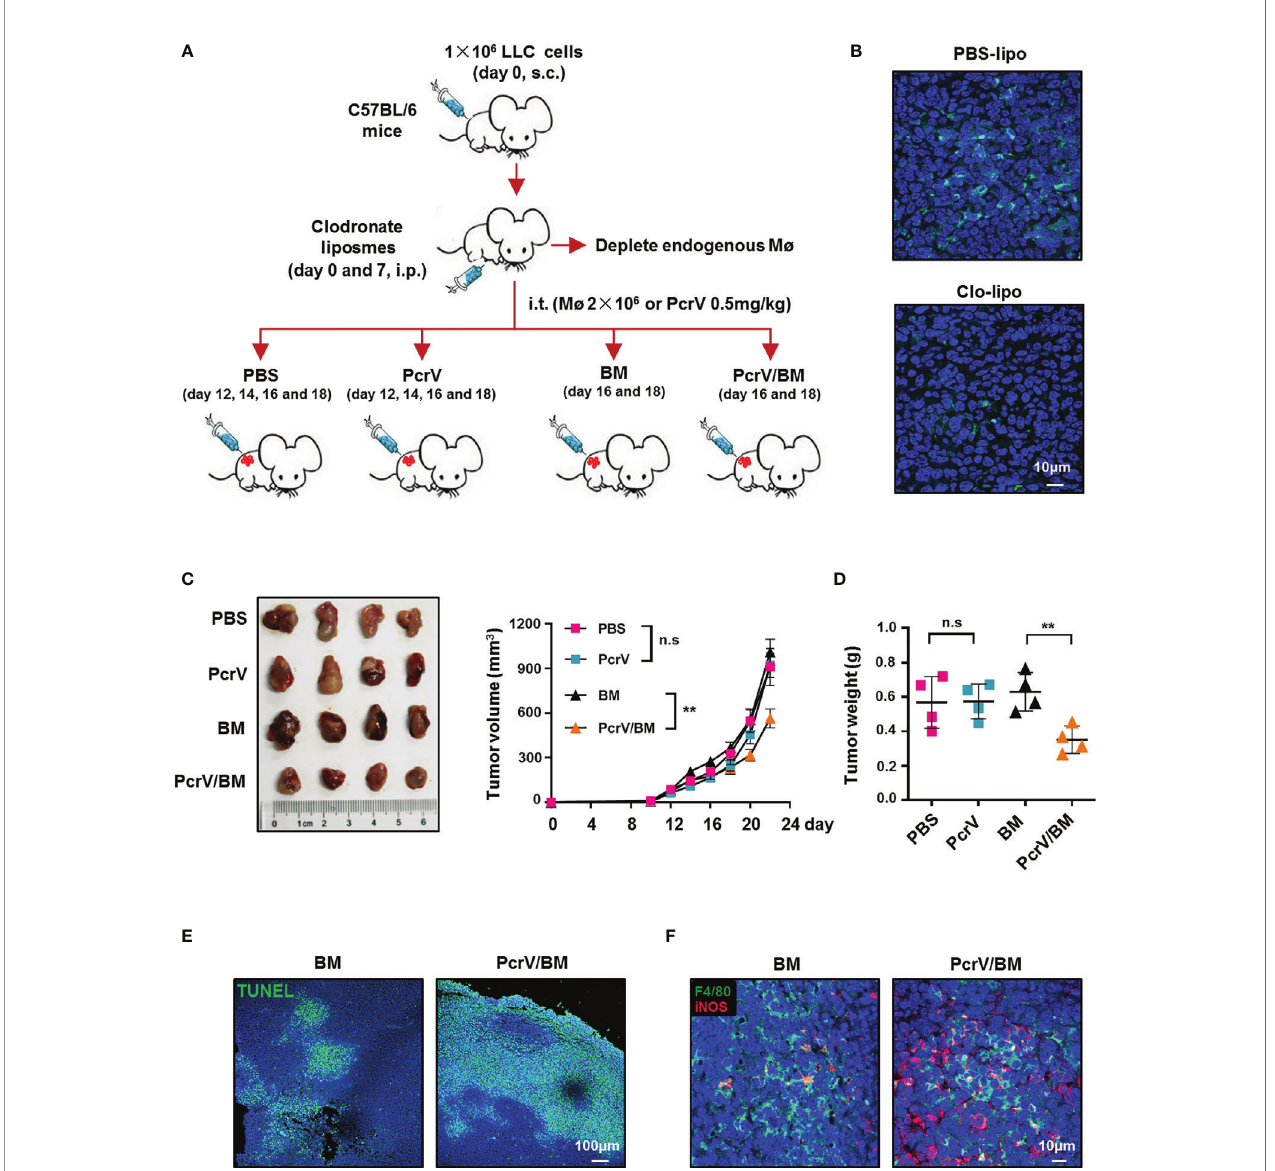
FIGURE 3 | PcrV-primed macrophages suppress tumor growth by increasing the levels of apoptosis and iNOS expression in tumor tissues. (A) Schematic of the mouse models used. (B) Immuno fl uorescence staining of F4/80 + macrophages in the tumor tissues (harvested on day 16) of mice treated with PBS liposomes or clodronate liposomes (day 0 and 7). Tumor growth (C) and weight (D) were measured in LLC cell-derived tumor-bearing mice treated with PBS, PcrV, or bone marrow-derived macrophages (BMDMs) primed or not with PcrV. (E) Apoptosis was detected by TUNEL assay. (F) iNOS protein level and F4/80 + iNOS + M1 TAMs in tumor tissues were detected by immuno fl uorescence staining. Data were expressed as means ± SEM ( C , n = 4) or means ± SD ( D , n = 4), and were analyzed by two-way ANOVA (C) or unpaired Student ’ s t -test (D) . ** p < 0.01. s.c, subcutaneous injection; i.p., intraperitoneal injection; i.t., intratumoral injection; BM, BMDMs; PBS-lipo, PBS liposomes; Clo- lipo, clodronate liposomes; iNOS, inducible nitric oxide synthase; PBS, phosphate-buffered saline; LLC, Lewis lung cancer. n.s, no signi fi